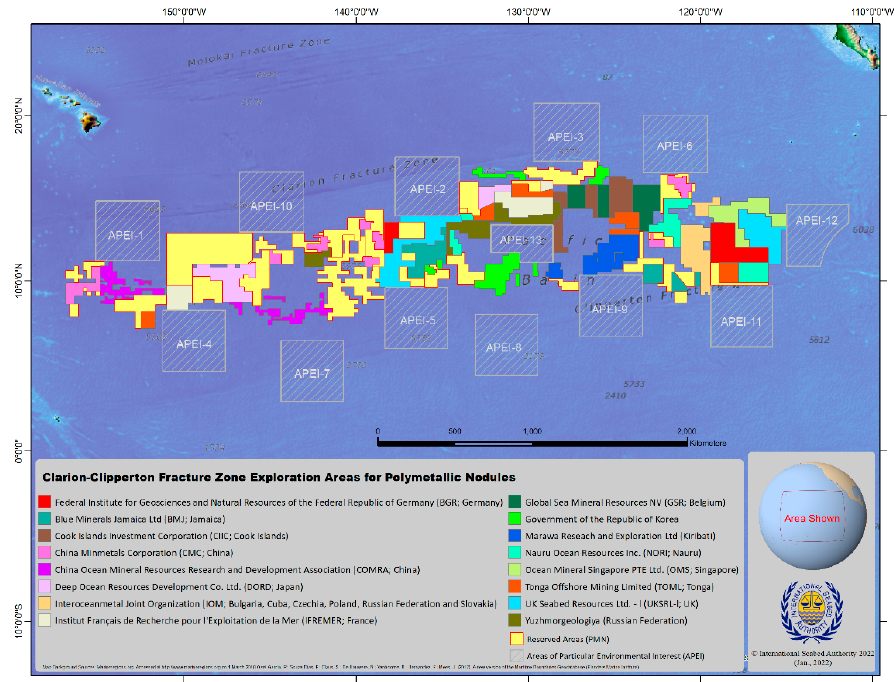
Figure 2. Clarion–Clipperton fracture zone exploration areas for polymetallic nodules [16], where the colors represent the corresponding polymetallic nodule contractors.